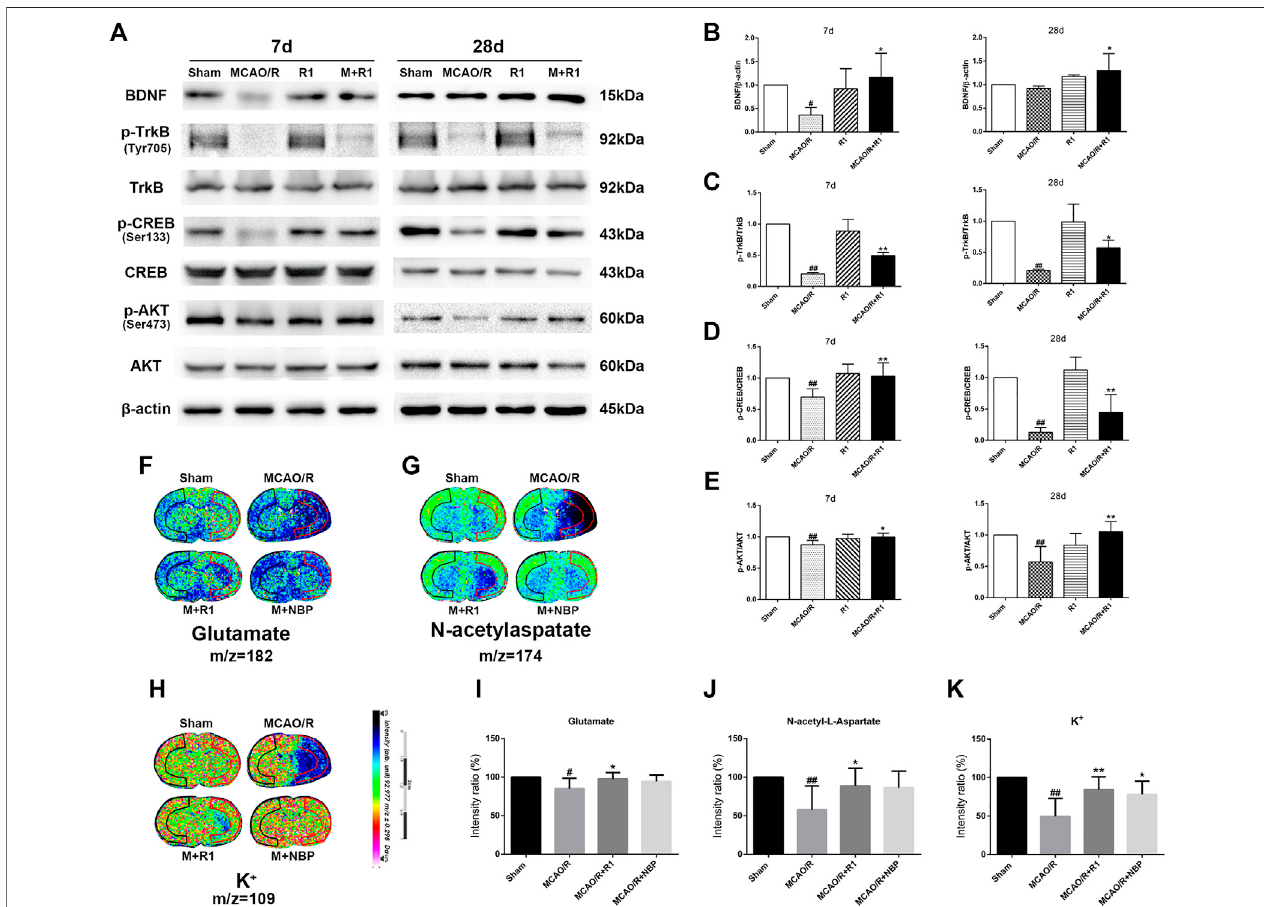
FIGURE 7 | R1 activates the BDNF/Akt/CREB signaling pathway to promote the recovery of neurological function. Representative images of immunoblotting (A) andquanti fi cationoftherelativeproteinlevelsofBDNF (B) , p -TrkB/TrkB (C) , p -CREB/CREB (D) and (E) p -Akt/AktintheinfarctcortexregionoftheSham,MCAO/R,R1, and MCAO/R + R1 groups on days 7 and 28 after MCAO surgery. n (cid:1) 3 in each group. In situ MALDI MSI of glutamate (F) , N-acetylaspatate (G) and K + (H) (I-K) Quantitativemeasurementofthecorrespondingindicatorsintheischemiccortex.Scalebar (cid:1) 2 cm, n (cid:1) 5ineachgroup.Dataareexpressedasthemean ± SDand were analyzed by ANOVA. # p < 0.05, ## p < 0.01 vs. Sham group; * p < 0.05, ** p < 0.01 vs. MCAO/R